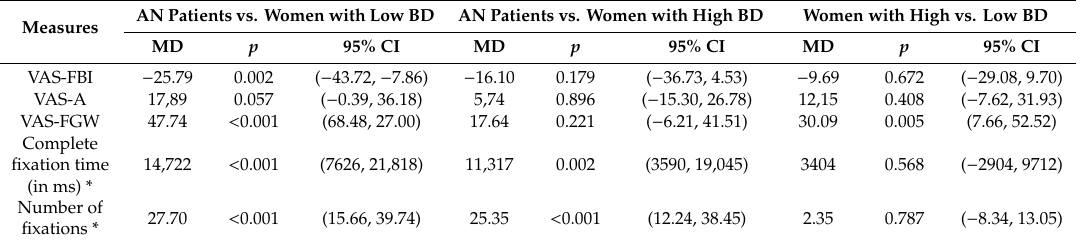
Table 2. Post-hoc analyses (pairwise comparison) between AN patients and women with high and low BD. AN Patients vs. Women with Low BD AN Patients vs. Women with High Measures